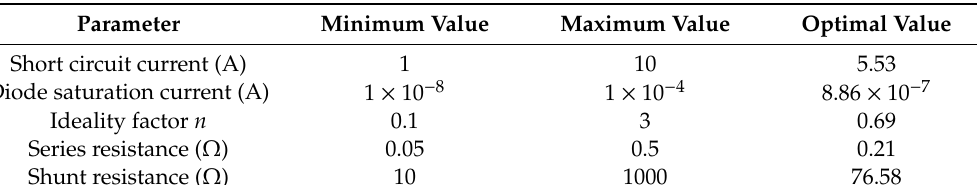
Table 3. Minimum, maximum and optimal values of five parameters of a single diode model of a PV panel.